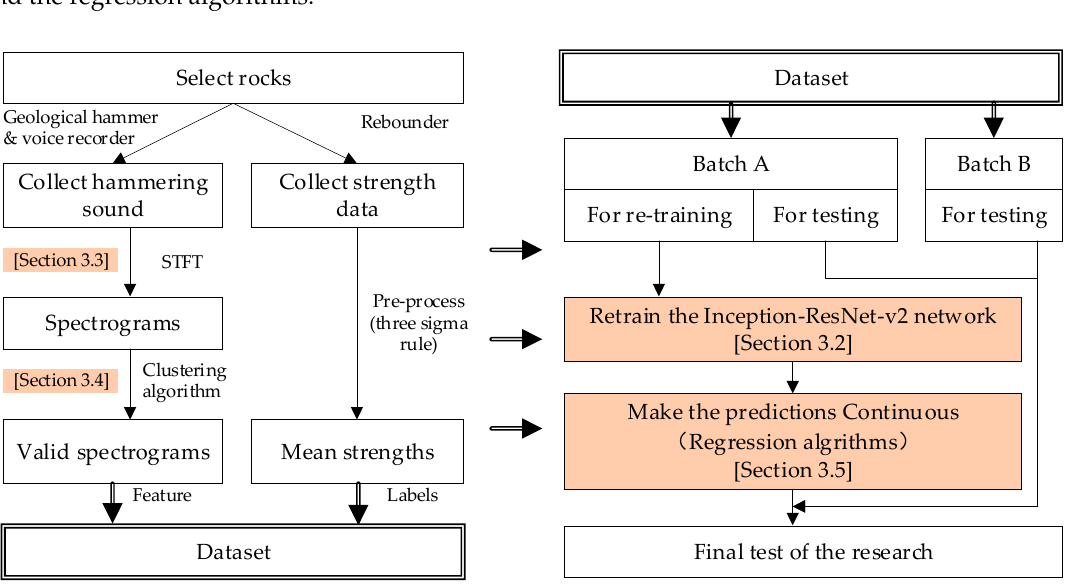
Figure 1. Flow chart of this research. The left scheme shows how to collect and process the data, the right scheme shows how to train the deep neural network (DNN) model and how to test our method.